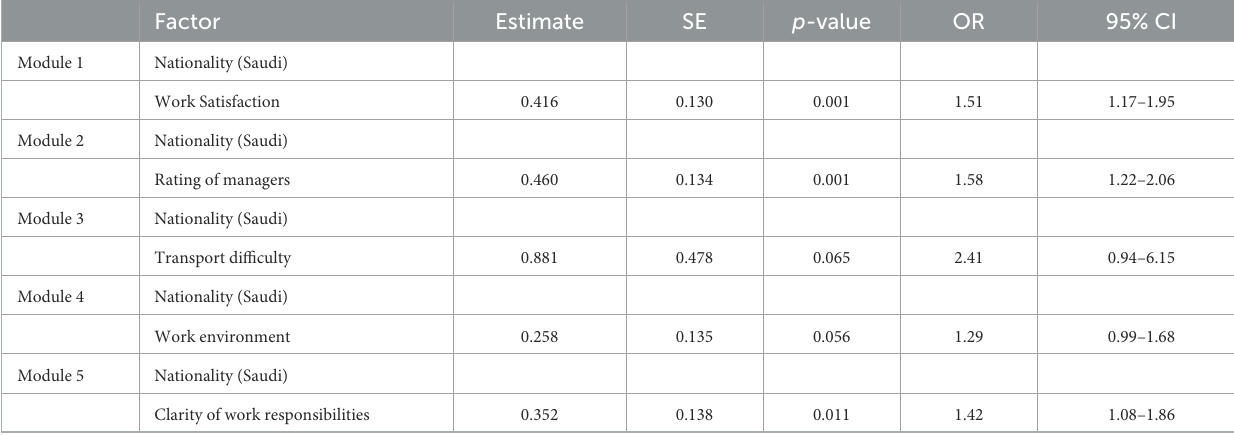
TABLE 4 Multiple logistic modules for different factors vs. nationality.